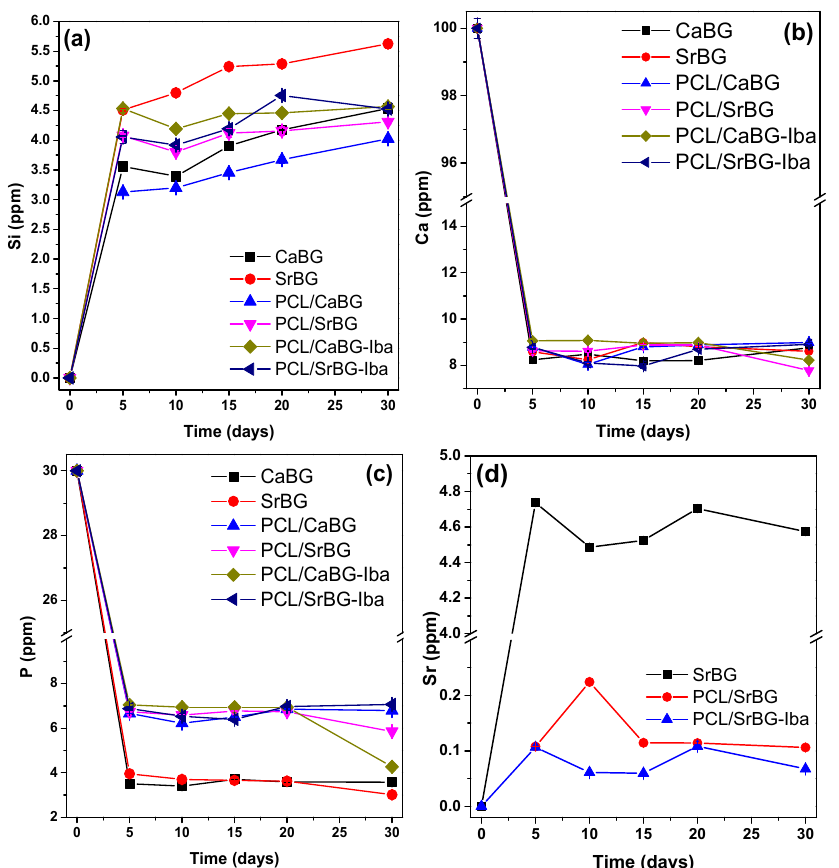
Figure 13. Release of ( a ) Si, ( b ) Ca, ( c ) P and ( d ) Sr ions from composite PCL films and pristine CaBG and SrBG BGs.